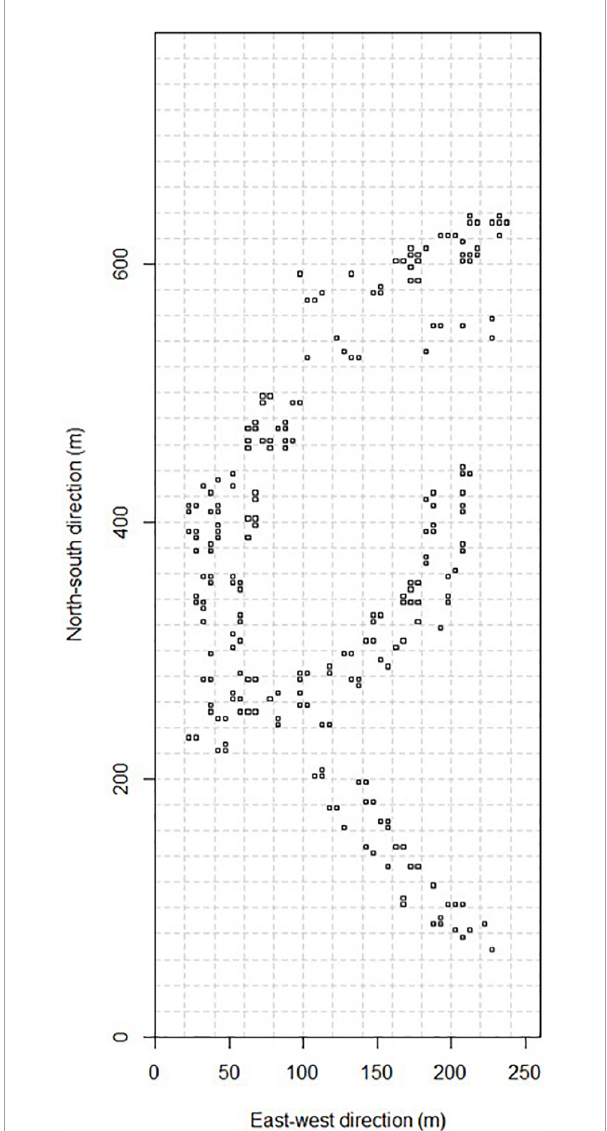
FIGURE1 Approximate positions of seedling plots in the 20.28 ha Ngel Nyaki Forest Dynamics Plot. Only seedling plots from which we sampled newly recruited seedlings are